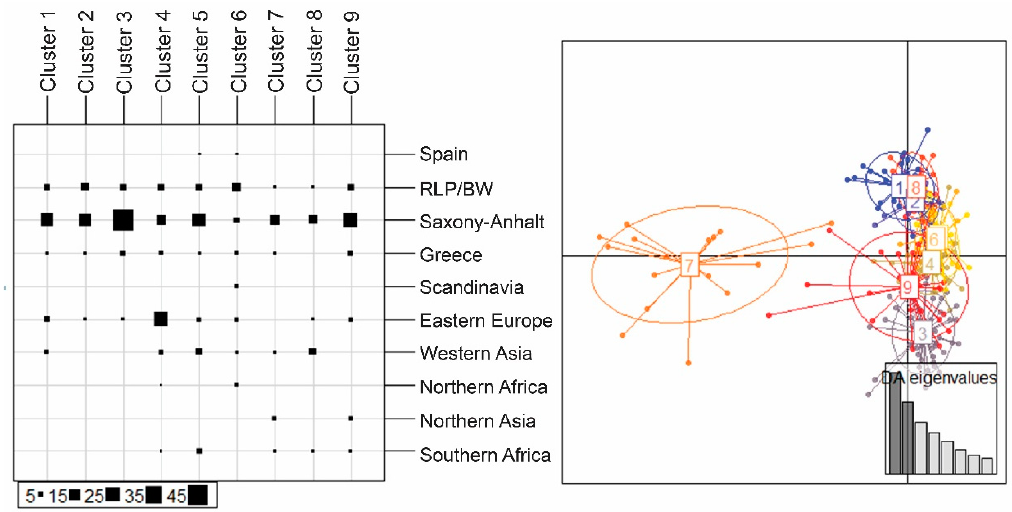
Figure 3. Discriminant analysis of principal components based on six microsatellite loci of Merops apiaster . The dots correspond to the individuals while the ellipses represent the clusters. Colors represent each different cluster. RLP/BW— Rhineland-Palatinate , Baden-Württemberg and Saxony- Anhalt (Germany).